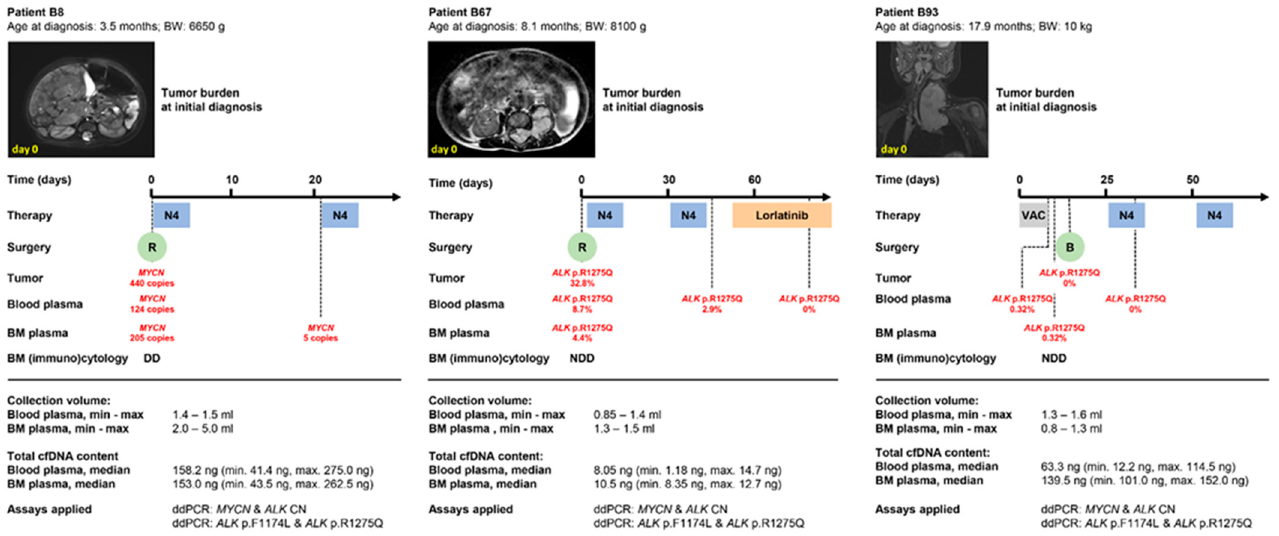
Figure 6. Overview of molecular ctDNA profiling results in 3 selected infants <18 months with neuroblastoma. Shown is the timeline from diagnosis through therapeutic interventions including drug therapies and surgery. Selected images reflect the tumor burden at initial diagnosis for patients B8 ( left panel ), B67 ( middle panel ) and B93 ( right panel ). Time points of bone marrow assessment by (immuno)cytology and droplet digital PCR (ddPCR) are summarized below the timelines. Sample volumes and cfDNA content available for ddPCR are also indicated. N4, chemotherapy regimen according to the NB2016 registry: doxorubicin, vincristine, cyclophosphamide; VAC, chemotherapy regimen according to the Cooperative Soft Tissue Sarcoma Study Group of the German Society of Pediatric Hematology and Oncology (GPOH): vincristine, actinomycin-D, cyclophosphamide. B, biopsy; BM, bone marrow; BW, body weight; R, resection; DD, disease detectable; NDD, no disease